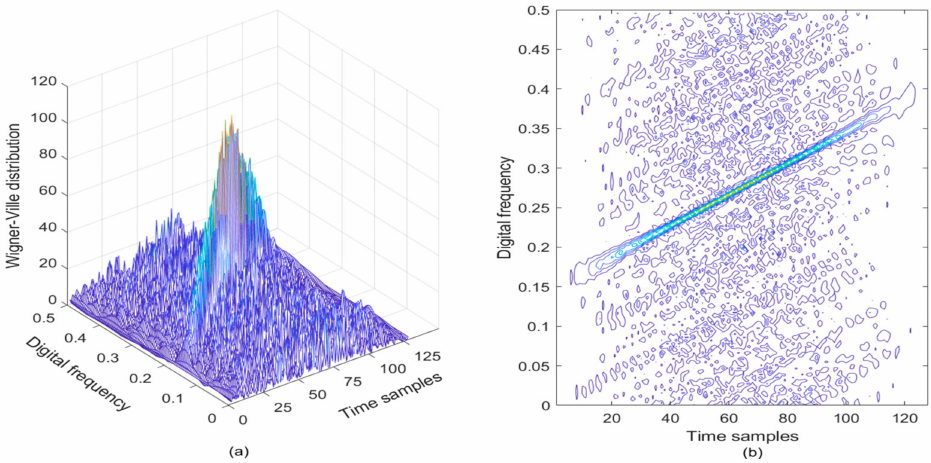
Figure 1. The WVD of LFM signal in the presence of AWGN, where the SNR is set to be 3 dB. ( a ) WVD of the noisy LFM signal; ( b ) Contour of